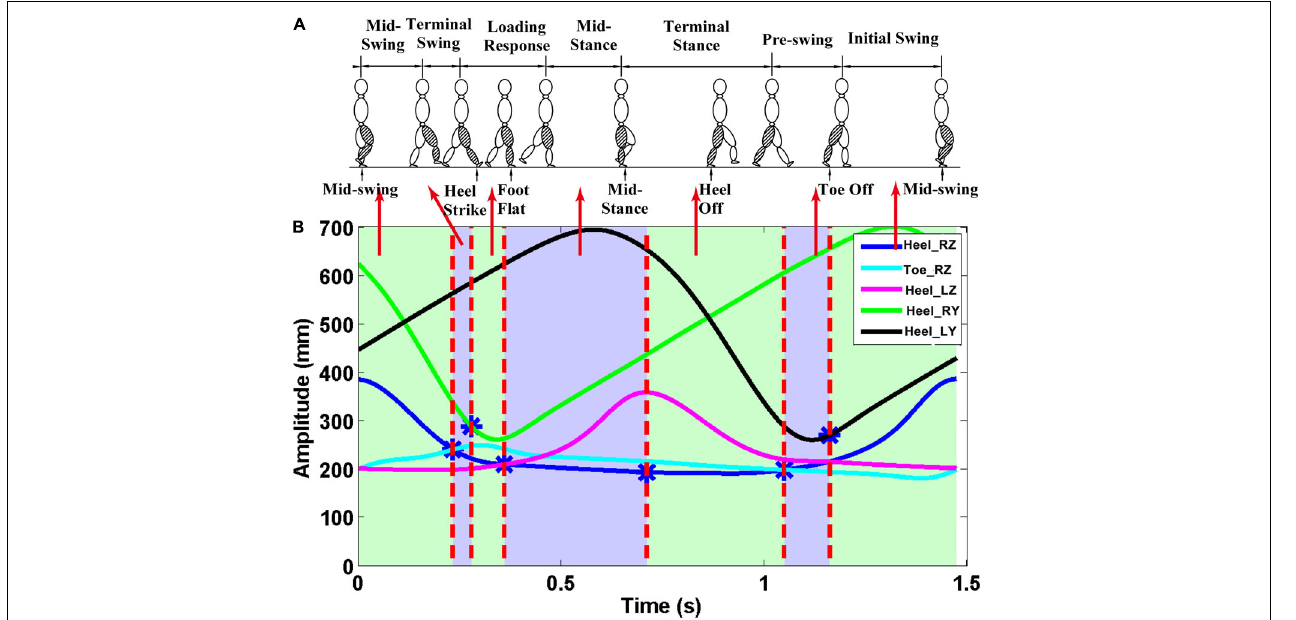
FIGURE 2 | Gait phase division results. The z -direction corresponds to the vertical direction, and the y -direction is the anteroposterior. (A) Seven gait phases of the gait cycle; (B) trajectory data. The first vertical red line—the first intersection of Heel_RZ and Toe_RZ. The second vertical red line—the point with the largest difference between Heel_RY and Heel_LY. The third vertical red line—the first intersection of the Heel_RZ and Heel_LZ. The fourth vertical red line—the maximum point of the Heel_LZ. The fifth vertical red line—the second intersection of the Heel_RZ and the Toe_RZ. Finally, the sixth vertical red line—the point with the smallest difference between the Heel_RY and the